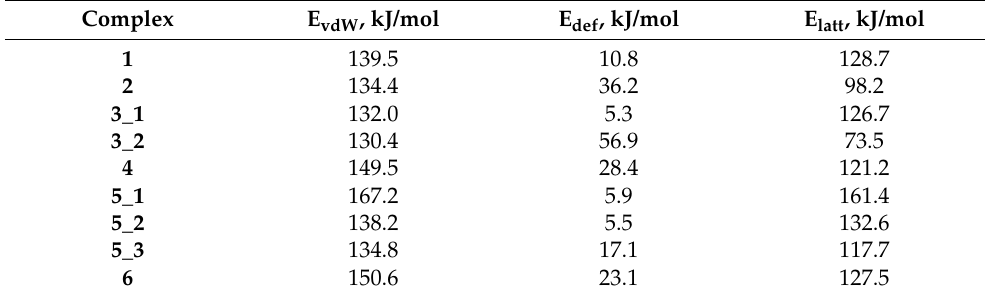
Table 5. Lattice binding energies per molecule (E vdW ), molecular deformation energies (E def ), and total lattice energies per molecule (E latt ) for complexes 1 – 6 .